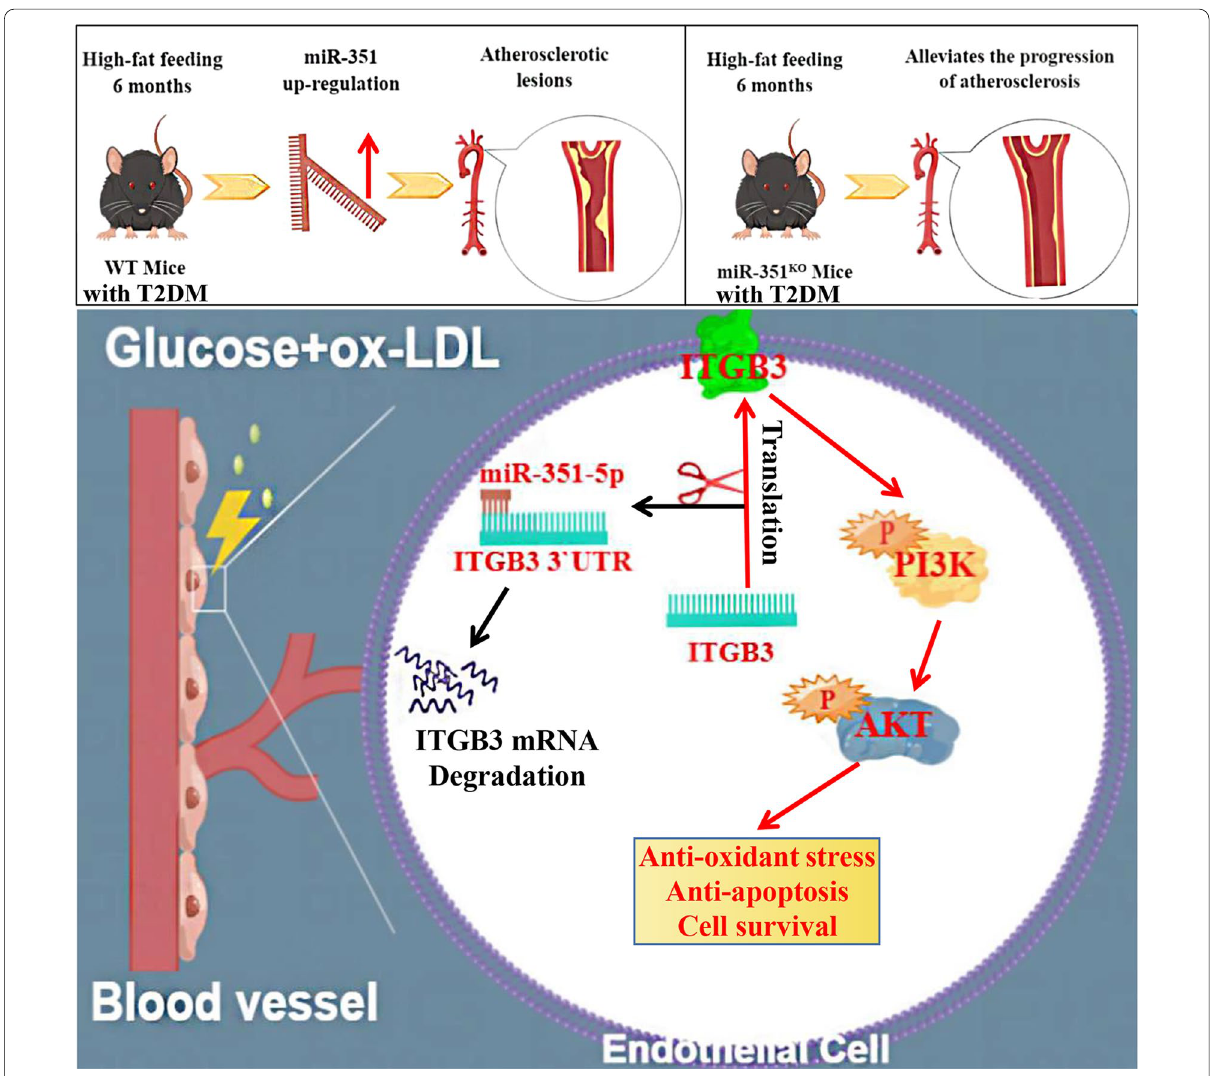
Fig. 11 miR-351 abolished ITGB3 expression and the PI3K/Akt pathway in high-fat diet-induced atherosclerosis in T2DM mice. In the high-fat diet-induced atherosclerotic T2DM mouse model, miR-351 was upregulated due to the influence of diabetes combined with a high-fat diet, while atherosclerosis was alleviated in the miR-351 KO mouse model. The reason is related to the inhibition of ITGB3 expression by miR-351 . Downregulated ITGB3 cannot stimulate the activation of the PI3K/Akt pathway, resulting in decreased cell resistance to oxidative stress and survival. After miR-351 is eliminated, ITGB3’s ability to stimulate the PI3K/Akt signaling pathway is restored, and endothelial cells can resist antioxidative stress and apoptosis and enhance cell